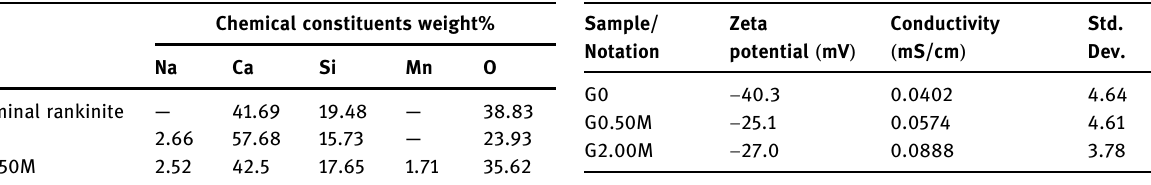
Table 3: The zeta potential